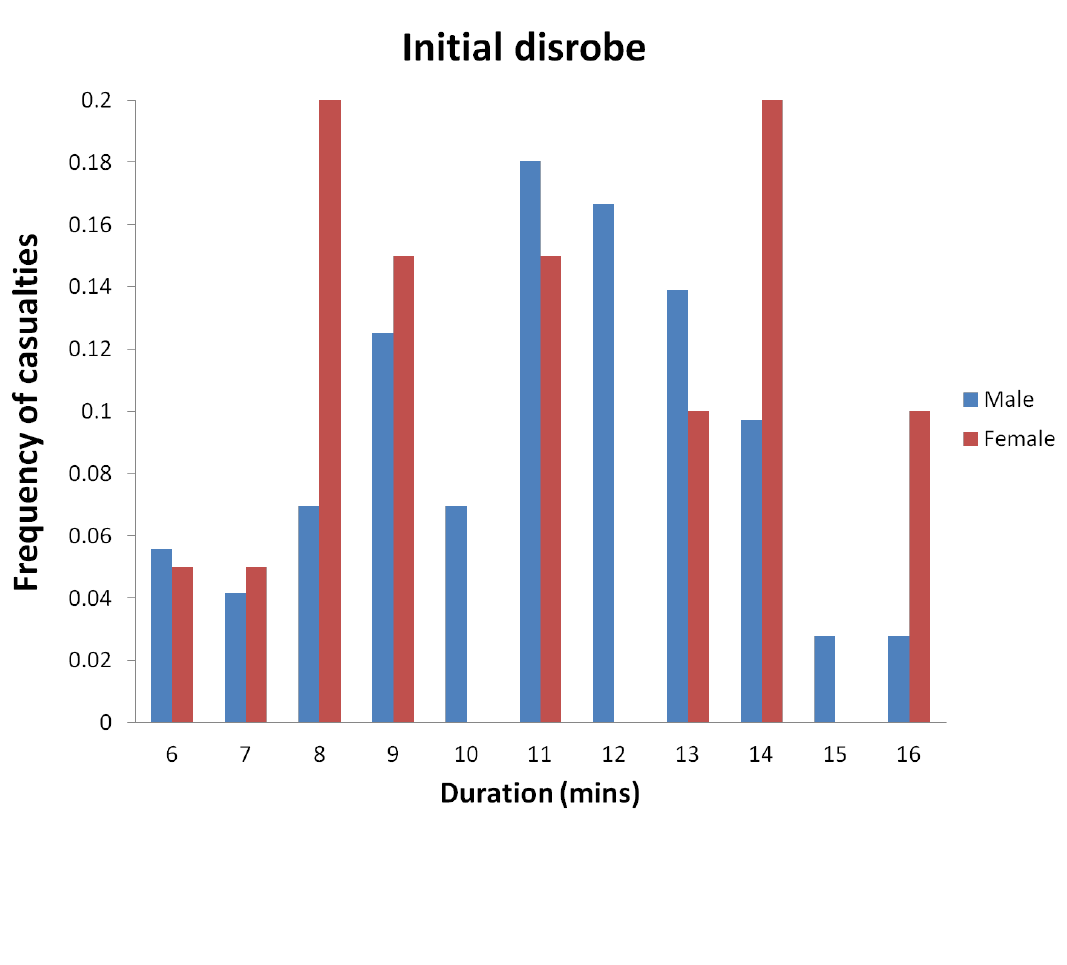
Figure A8. The time taken to perform the initial disrobe at the casualty collection point was captured for 72 males and 20 females. To complete their initial disrobe both males and females took on average 10.5 minutes, and no males nor females took less than 5 minutes or more than 16